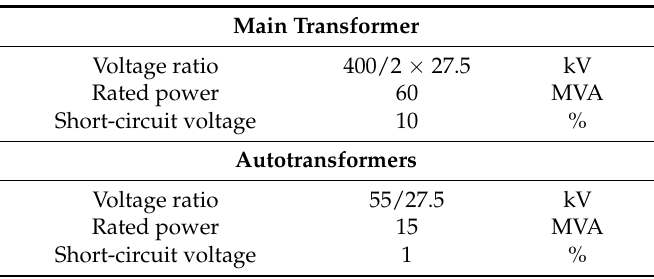
Table 2. Transformers and autotransformers ratings used in the simulation.